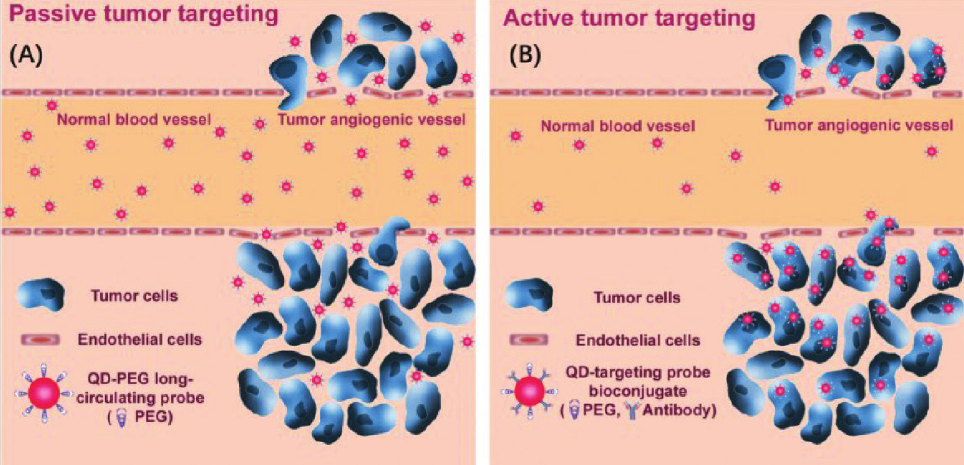
Figure 6: (a) Passive targeted imaging of quantum dots; (b) active targeted imaging of quantum dots . Reprinted image with permission from Ref. [28], Copyright 2004, Springer